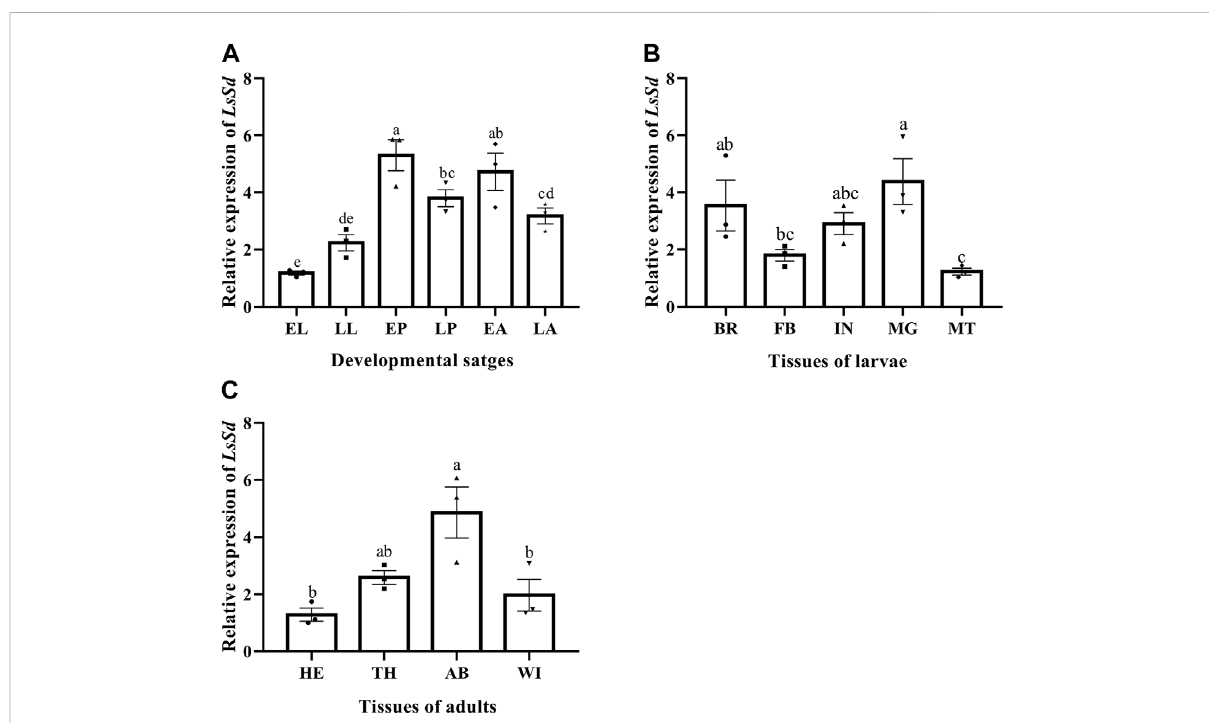
FIGURE 2 LsSd expression in the different developmental stages (A) , different larval tissues (B) and different adult tissues (C) of L. serricorne . EL, early larvae; LL, late larvae; EP, early pupae; LP, late pupae; EA, early adults; LA, late adults; BA, brain; FB, fat body; IN, integument; MG, midgut; MT, Malpighian tubules; HE,head; TH, thorax;AB, abdomen; Wing, WI. Error barsindicate theSEM of three independent biological replications.Different letters above the bars show signi fi cant differences at the 0.05 level (one-way ANOVA followed by Tukey ’ s test).